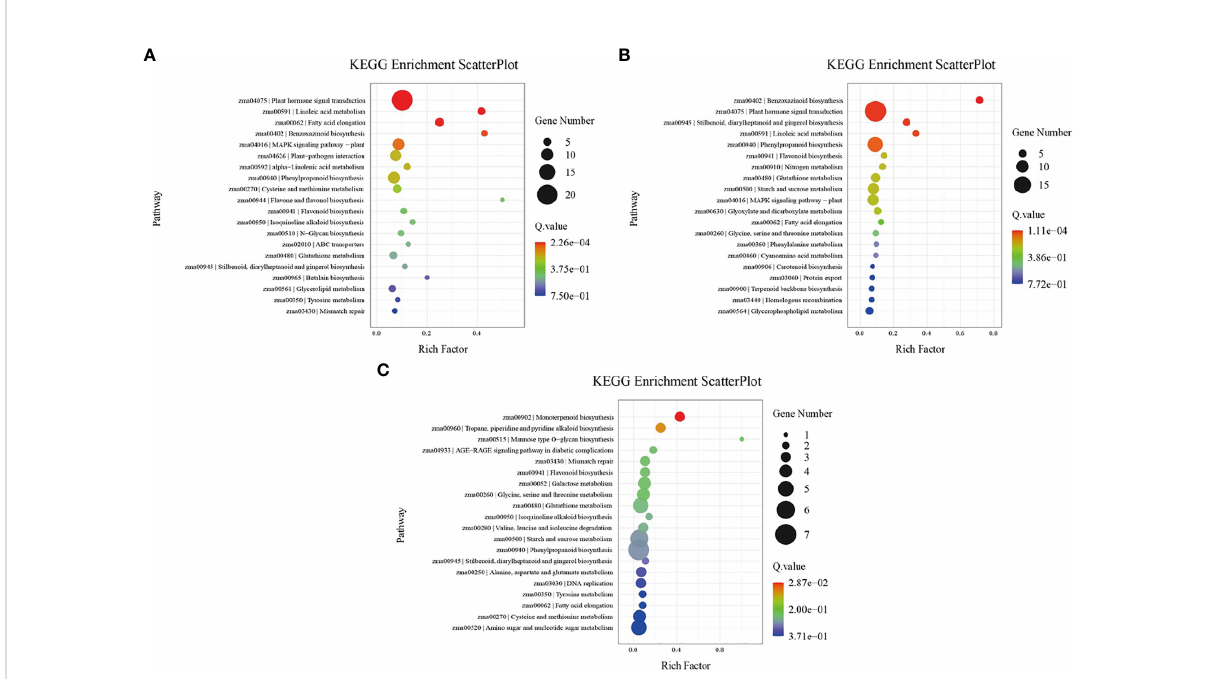
FIGURE 6 KEGG pathway enrichment analysis of DEGs in B73 and bhlh112 under the different treatments. (A) b112_CKvsB73_CK; (B) b112_AvsB73_A; (C) b112_IvsB71_I. CK = control, A = exogenous ABA, I = exogenous